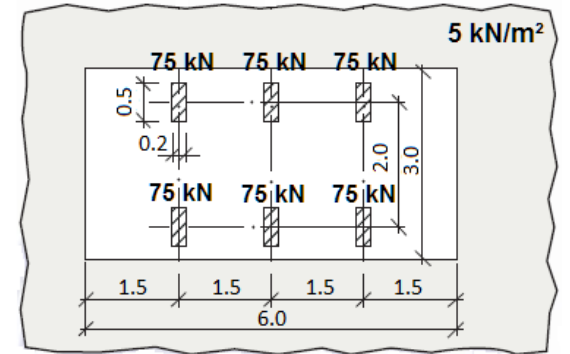
Figure 1. Brazilian live load model, dimension in meters (adapted from NBR 7188